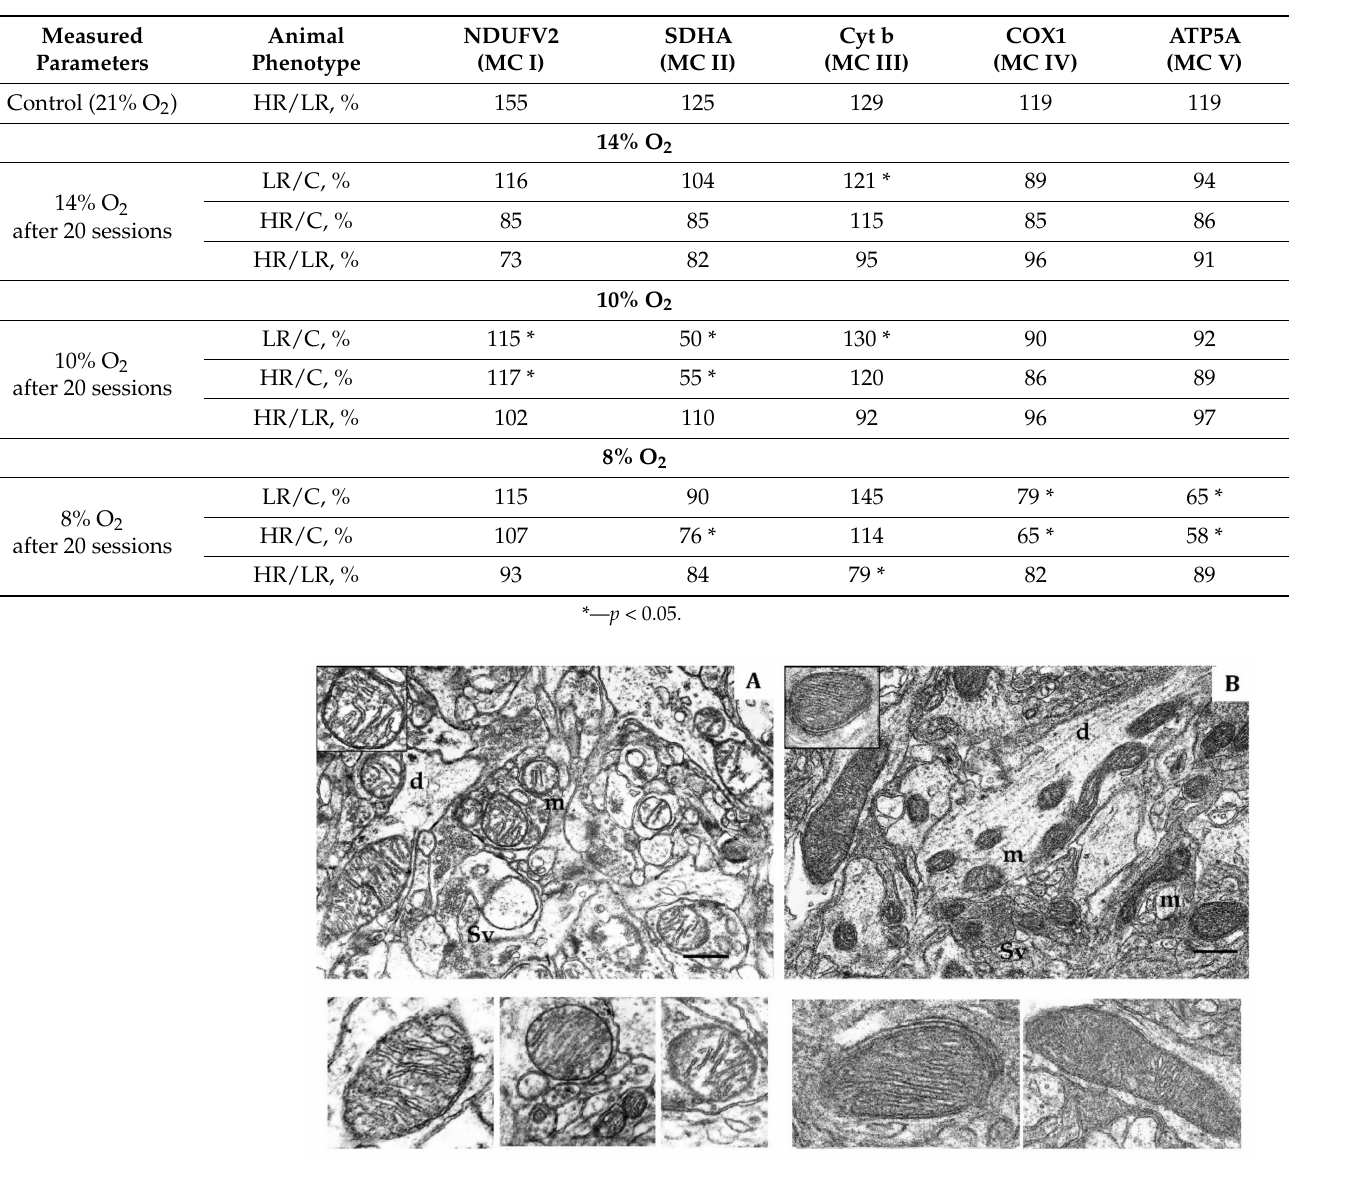
Figure 1. Electron micrography of rat cerebral cortex in normoxic conditions (21% O 2 ). ( A ) rats with low-resistance to hypoxia; ( B ) rats with high-resistance to hypoxia. d, dendrite; m, mitochondria; Sv, synaptic vesicles. Scale bar: 0.5 µ m. The bottom panels show representative